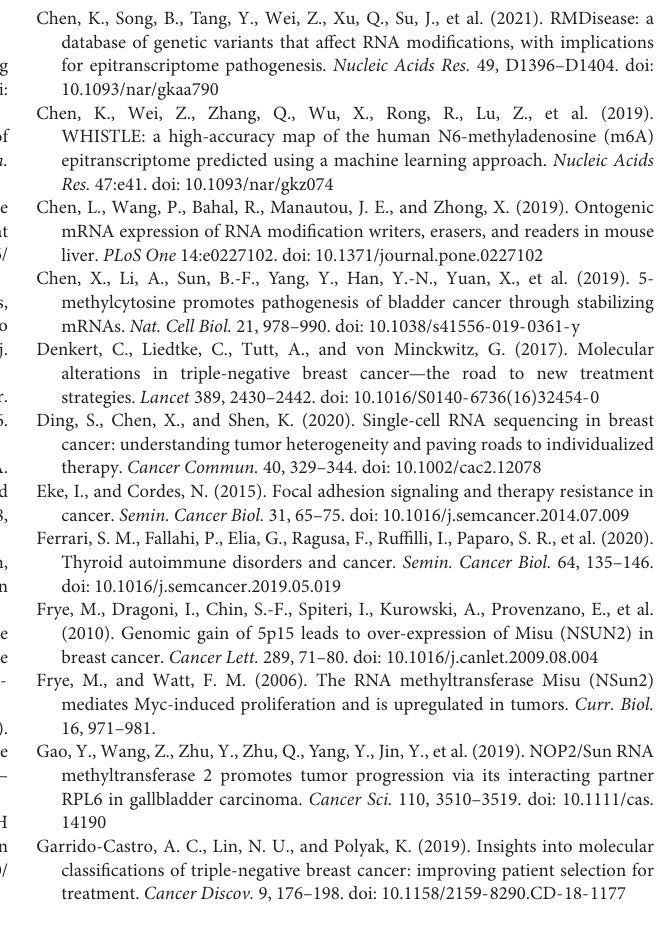
Supplementary Figure 1 | Differential expression heatmap and violin plot of m5C RNA methylation regulators in Luminal BC, and HER2 positive BC from the Human Cancer Gene Atlas. ∗ p < 0.05, ∗∗ p < 0.01, and ∗∗∗ p < 0.001. Luminal BC, luminal breast cancer; HER2 positive BC, human epidermal growth factor receptor 2 positive breast